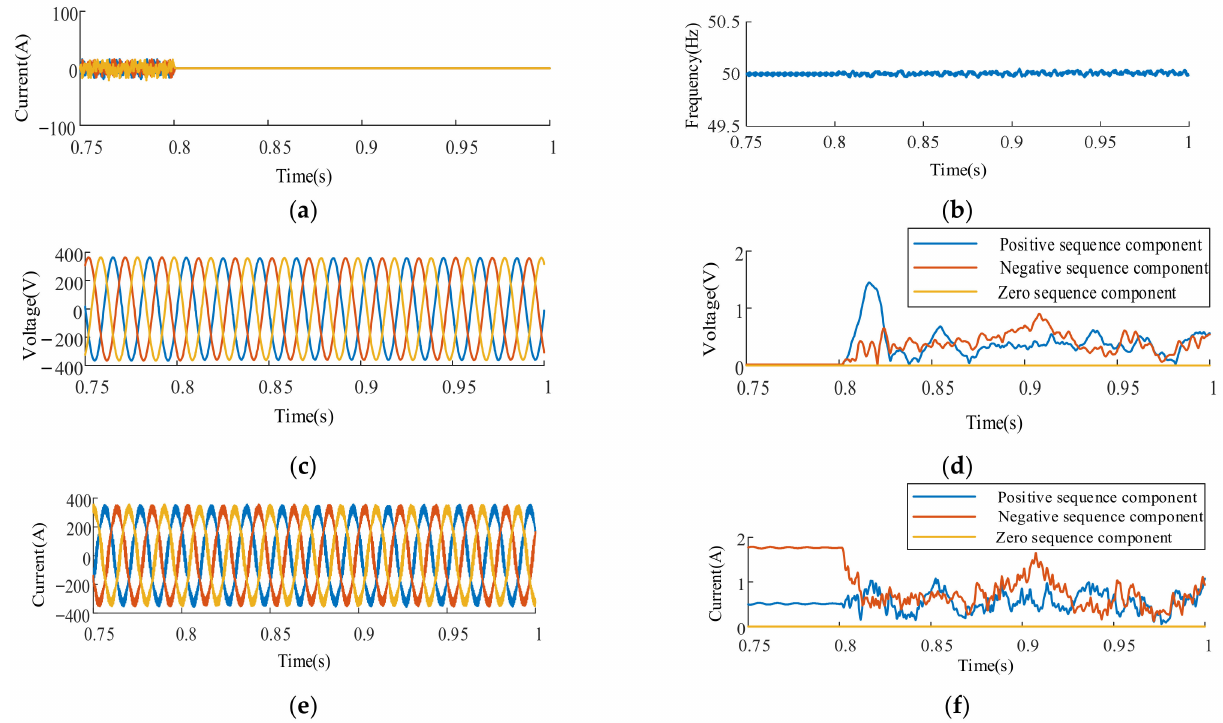
Figure 3. Islanding simulation waveforms with the loaded quality factor Q f = 1: ( a ) The current flowing into the grid; ( b ) System’s voltage frequency; ( c ) The voltage at the PCC; ( d ) The second harmonic symmetrical components of the measured voltage; ( e ) Inverter output current; ( f ) The second harmonic symmetrical components of the measured